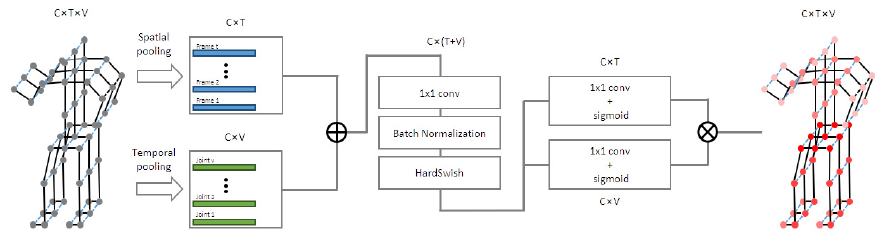
Figure 6. Overview of the proposed ST-GCN module, where C, T, and V denote the numbers of input channels, frames, and joints, respectively.